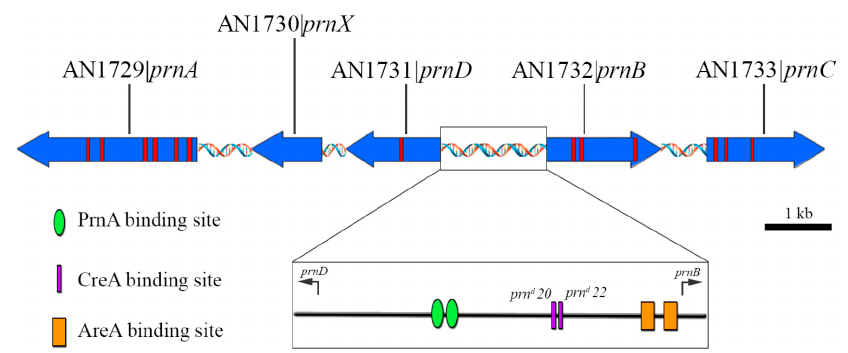
Figure 3. Schematic representation of the prn gene cluster organization in chromosome VII of A. nidulans . prnB (AN1732) encodes the specific proline transporter, prnD (AN1731) codes for proline oxidase, prnC (AN1733) for Δ 1-pyrroline-5-carboxylate dehydrogenase, prnA (AN1729) for the pathway specific transcriptional activator and prnX (AN1730) is a proline-inducible gene of unknown function (see text). Genes are presented in scale with their standard names followed by their systematic names in the AspGD bank (http://www.aspgd.org/). Introns are shown red and the direction of transcription is indicated by the arrow-like gene boxes. The inset represents a zoom in the boxed area, the prnB–prnD intergenic region, where the relative position of the two physiologically relevant PrnA- (green oval), CreA-, corresponding to prn d 20 and prn d 22 mutations, (purple rectangles) and AreA- binding sites (orange rectangles) are shown.